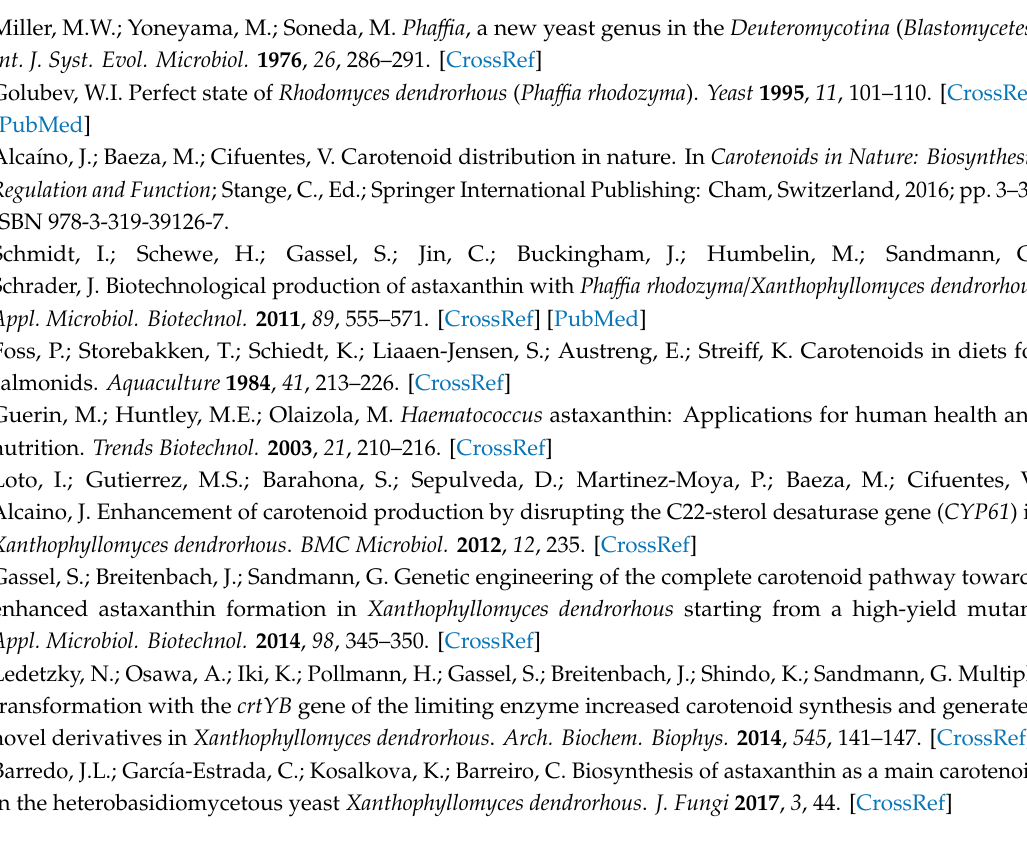
Table S1: Localization of the genes encoding enzymes of the astaxanthin biosynthetic pathway in the draft genomes of P. australis and P. tasmanica , Figure S1: (A) Sequence similarity between the new species Pha ffi a australis and P. tasmanica and P. rhodozyma along the longest sca ff old (sca ff old 52) of P. rhodozyma CBS 6938. The left scale represents the divergence measured by a sliding window approach to P. rhodozyma CBS 7918 (red), P. rhodozyma CRUB 1149 (blue), P. australis PYCC 6859 (yellow) and P. tasmanica PYCC 6858 (magenta). The mean divergence value for each strain is shown using the color-codes indicated above. The right Y scale represents the percentage of Ns in the reference sequence, which are indicated as grey bars (1.5% of the sca ff old sequence corresponded to Ns). (B) Genomic sequence divergence using an alignment-free method. Heat map and clustering with pairwise distances (Kr values) between the draft genomes of P. rhodozyma CBS 7918, CRUB 1149 and CBS 6938, P. tasmanica PYCC 6858, P. australis PYCC 6859, Cystofilobasidium bisporidii PYCC 4415, Cy. macerans PYCC 8515, Cy. capitatum PYCC 4530 and Cy. ferigula PYCC 4410, Figure S2: Amino acid alignments of the proteins involved in the astaxanthin biosynthetic route in Pha ffi a spp., Figure S3: Predicted proteins of the pheromone receptor genes of P. australis and P. tasmanica . The transmembrane domains of each sequence are highlighted in blue, Figure S4: Predicted proteins of the homeodomain transcription factor genes of P. australis and P. tasmanica . The secondary organization is